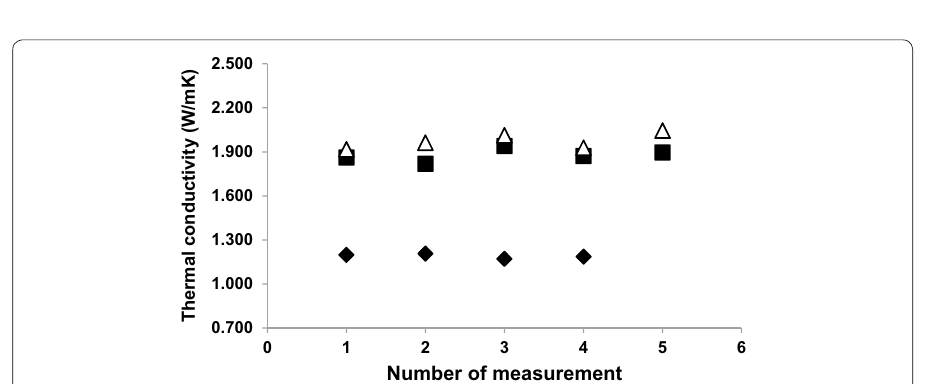
Fig. 2 Diagram of the repeated measurements of thermal conductivity obtained on the starting and doped ( 5 and 10% of graphite powder) bentonitic grouts. Symbols are as follows: diamonds for the starting + + grout; squares for the grout 5% of graphite powder; triangles for the grout +